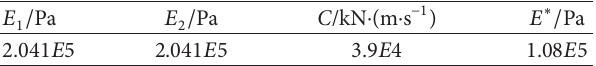
Table 2: Constitutive parameters of the viscoelastic